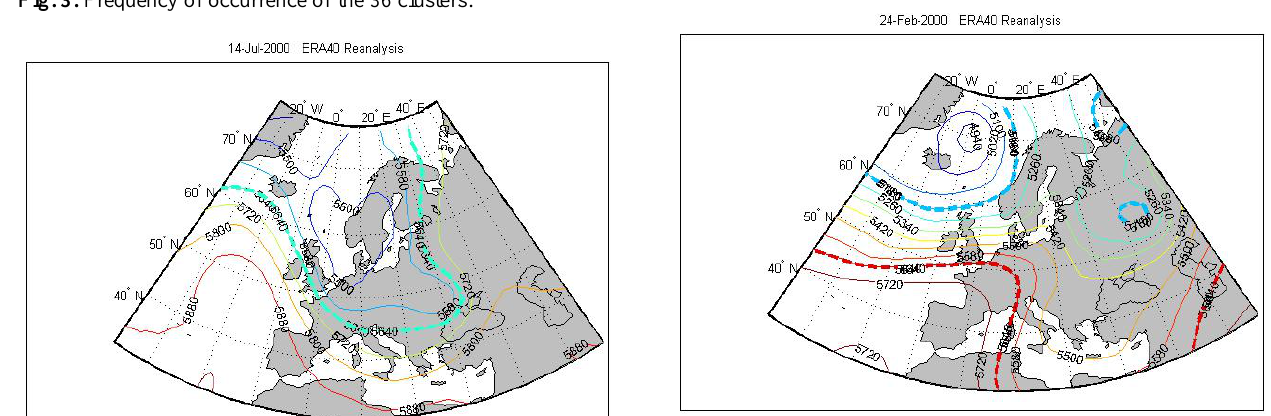
Fig. 4. Typical pattern of Cluster 24: 14 July 2000 (units: gpm). Fig.4. Typical pattern of Cluster 24: 14 July 2000 (units: gpm).